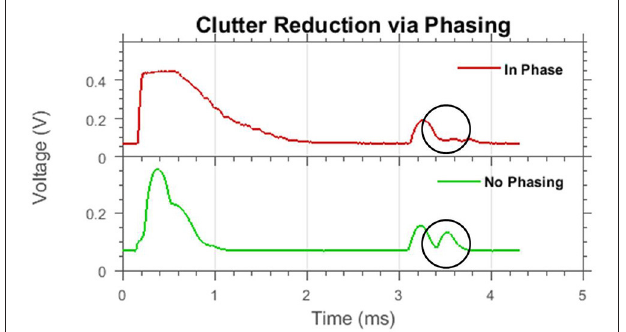
FIGURE 12 | A best-case example of clutter reduction using beam shaping. Shown are two echo traces from the same scene with different beam shapes. Two objects are present, the first echo is the target object ( ∼ 3.2ms); the second echo is from the clutter object ( ∼ 3.5ms) which is circled. When in-phase firing is used, the clutter echo is greatly reduced in amplitude.